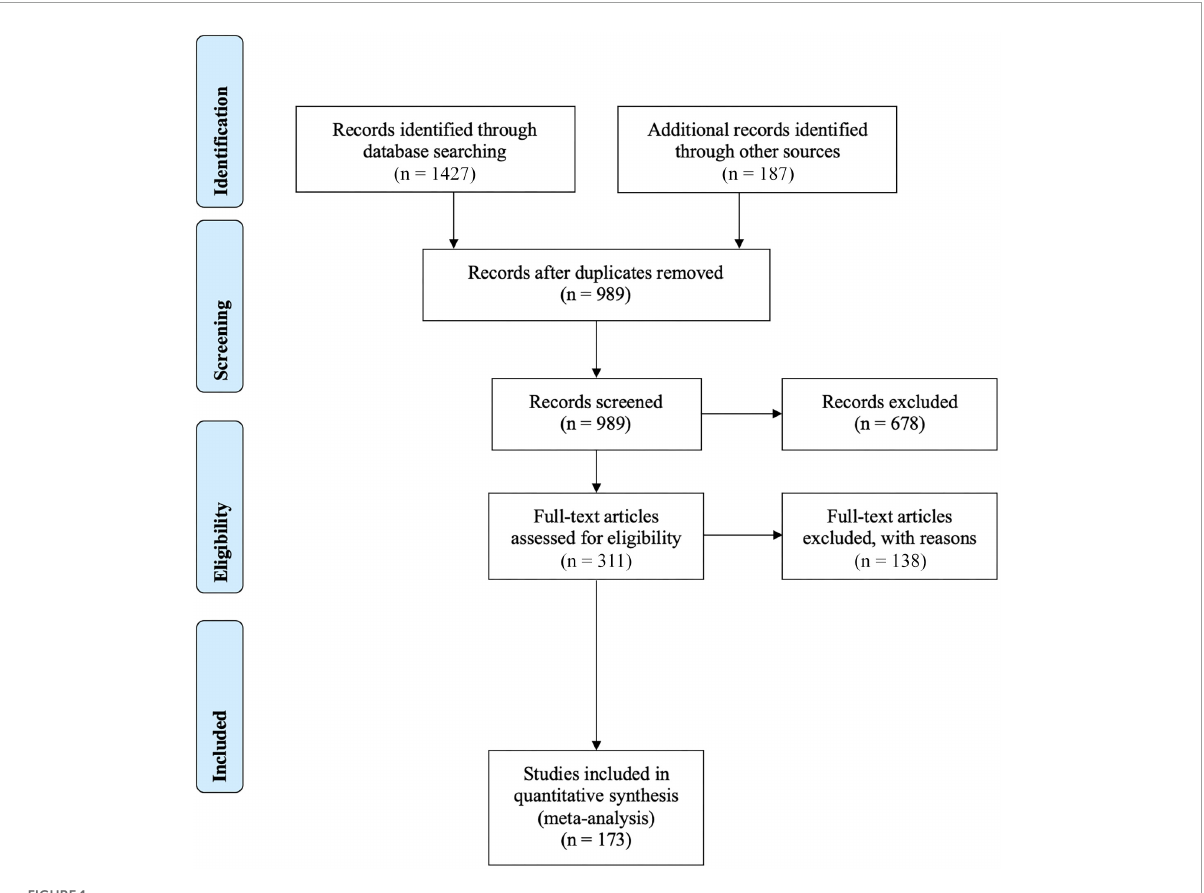
FIGURE1 PRISMA flowchart for inclusion of